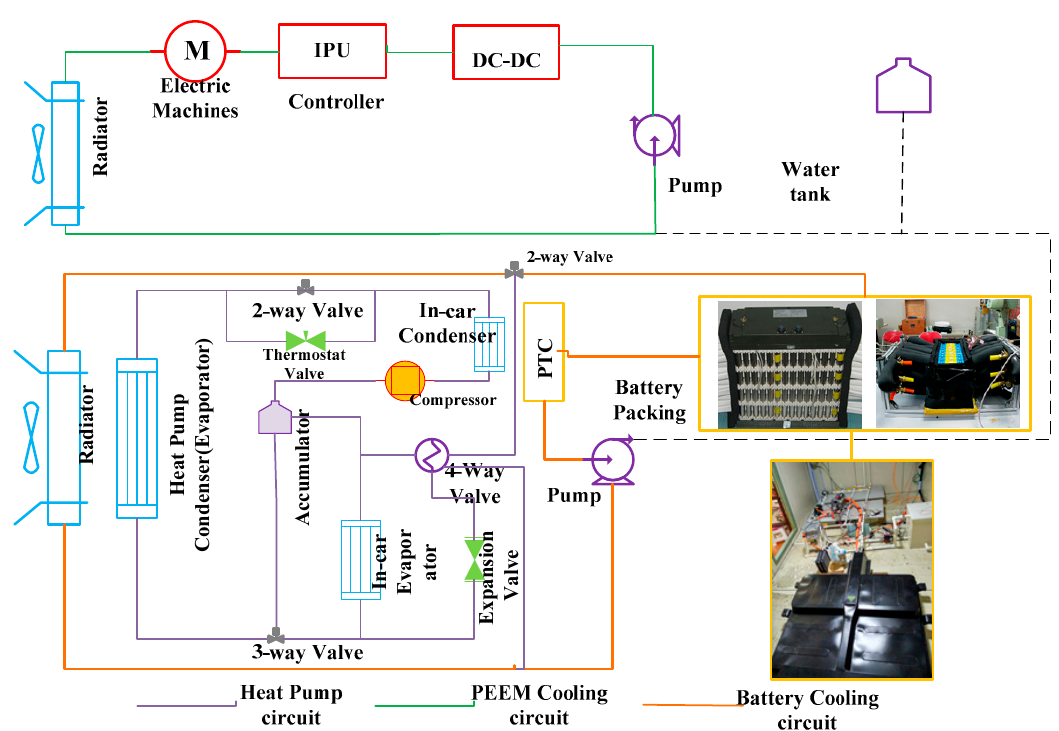
Figure 12. The schematic diagram the advanced vehicle ITM